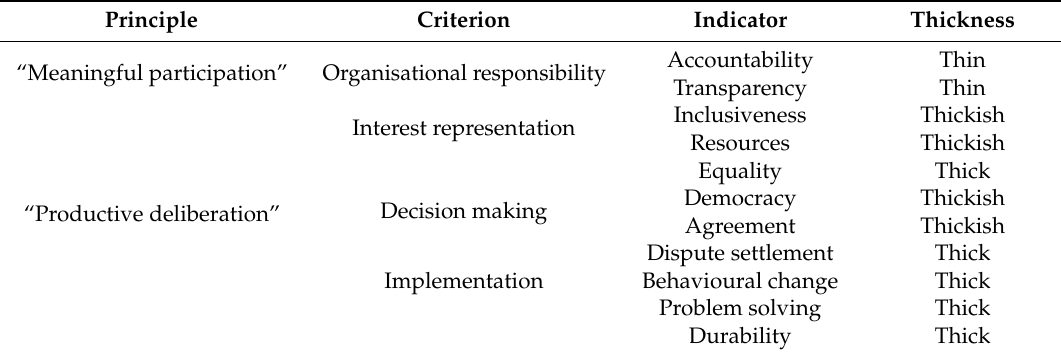
Table 1. Hierarchical framework of governance values. 1